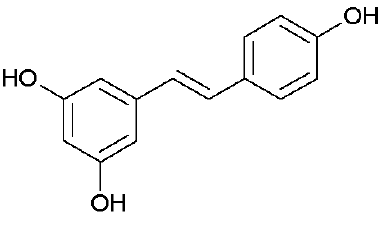
Figure 1. Trans -resveratrol.